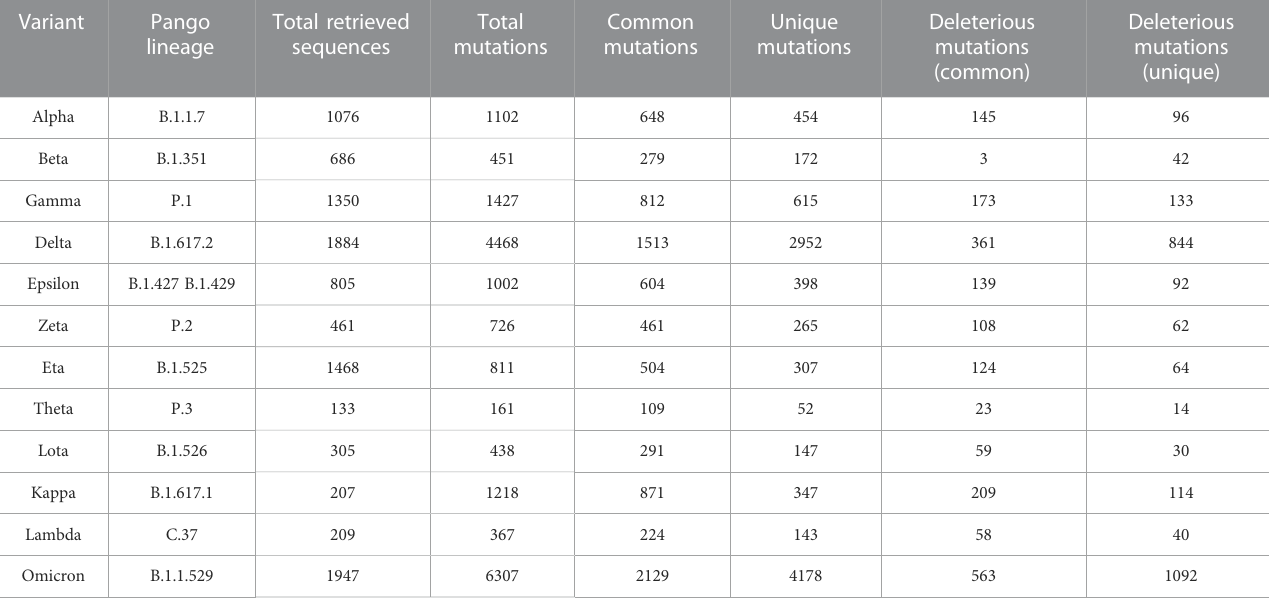
TABLE 1 Comparative view of different types of mutations in 12 variants of SARS-CoV-2.